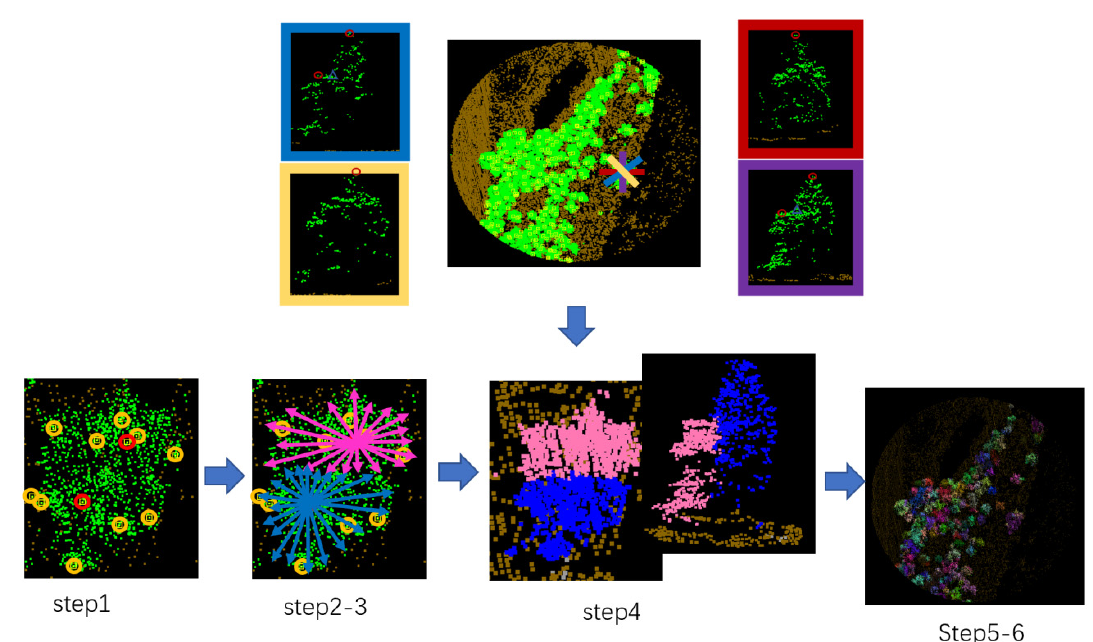
Figure 7. The workflow of tree points crown segmentation by a rotating profile analysis algorithm (RPAA).